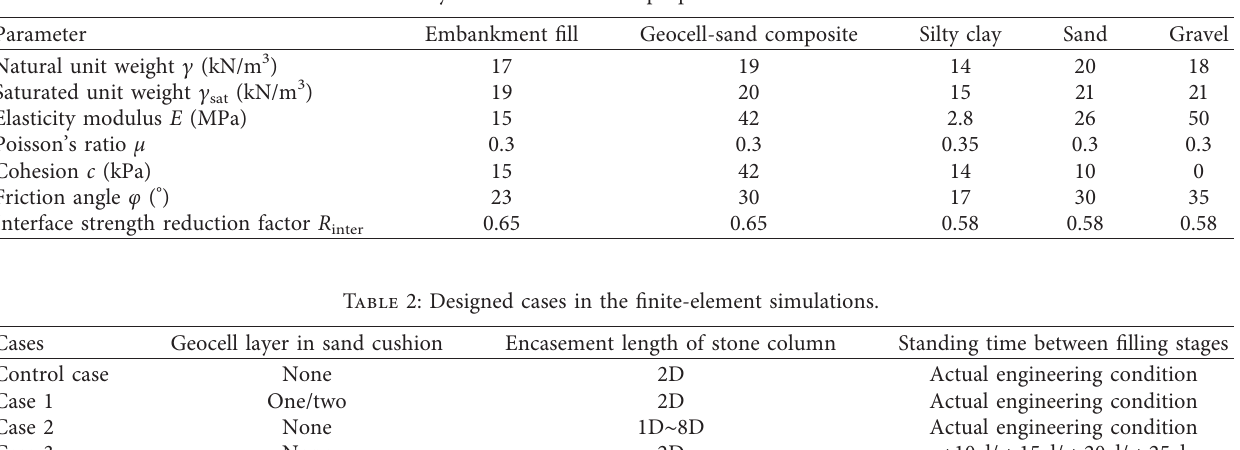
Figure 3: Designed numerical Table 1: Physical and mechanical properties of the materials.